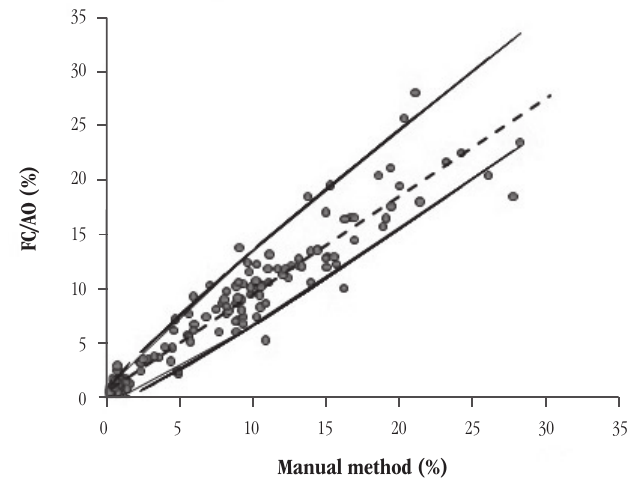
figurE 3 – Reticulocyte count (%) by manual method and FC using AO ( n = 150) Continuous lines; binomial CI 95%; dashed line: linear regression between the evaluated methods; Y = 0.524 + 0.899X; r 2 = 0.912; r = 0.955. FC: flow cytometry; AO: acridine